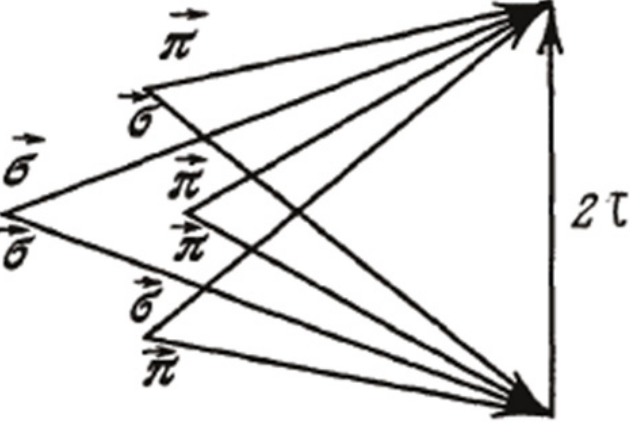
Figure 1. Second order Bragg conditions in vector form for a CLC with a strong local birefringence.